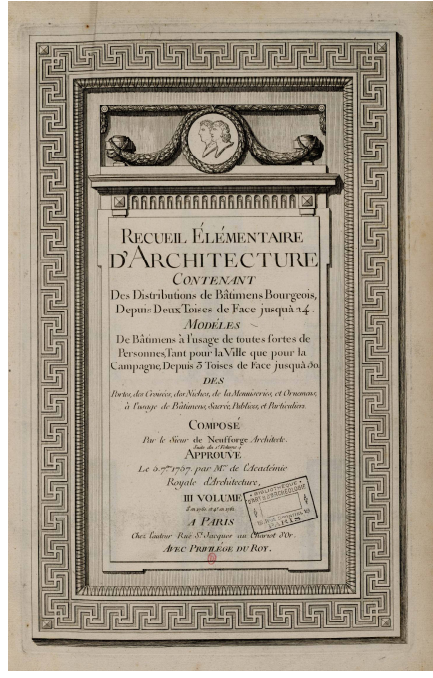
Figure 1. Frontispiece of Volume